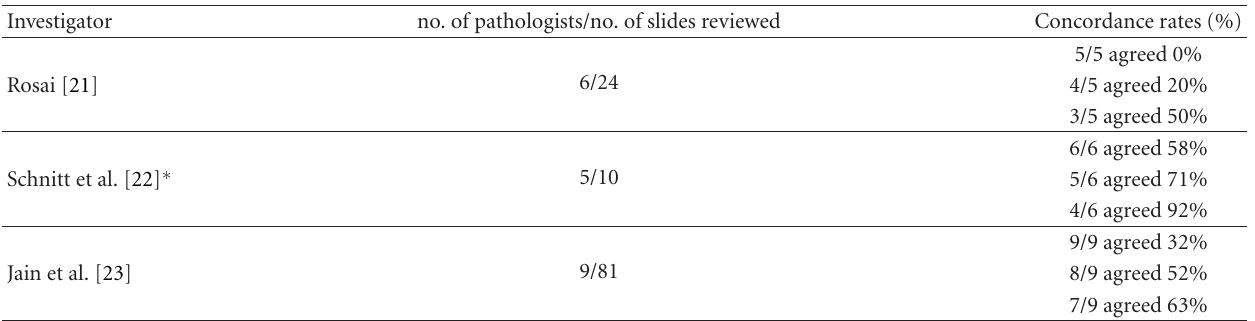
Table 1: Interobserver variability among pathologists in cases of borderline ductal proliferative lesions. Investigator